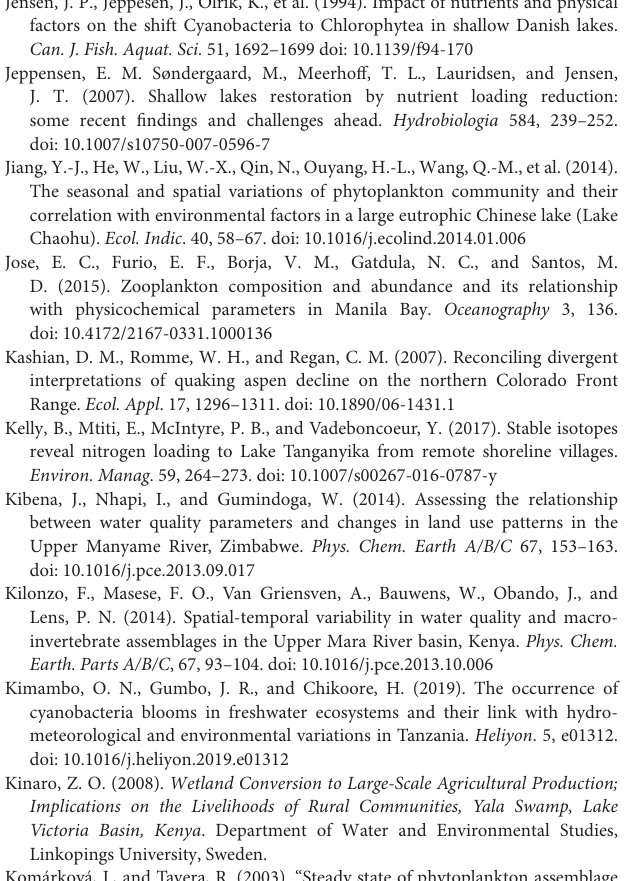
Figueredo, C. C., and Giani, A. (2009). Phytoplankton community in the tropical lake of Lagoa Santa (Brazil): conditions favoring a